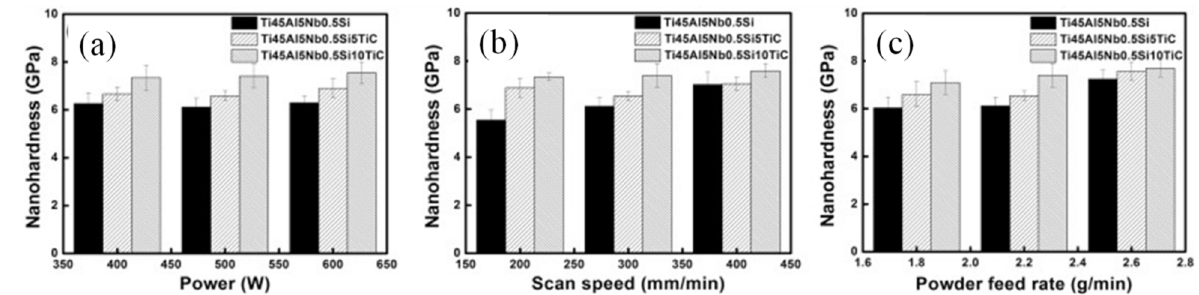
Figure 4. Nanohardness of laser-processed Ti45Al5Nb0.5Si-xTiC (x = 0, 5, and 10) composites as a function of ( a ) power, ( b ) scan speed, and ( c ) powder feed rate. Reprinted with permission from ref. [91]. Copyright 2021